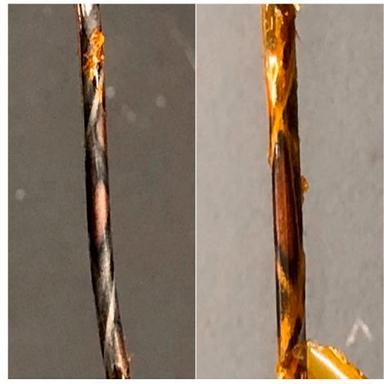
Vacuum polyimide conductors.